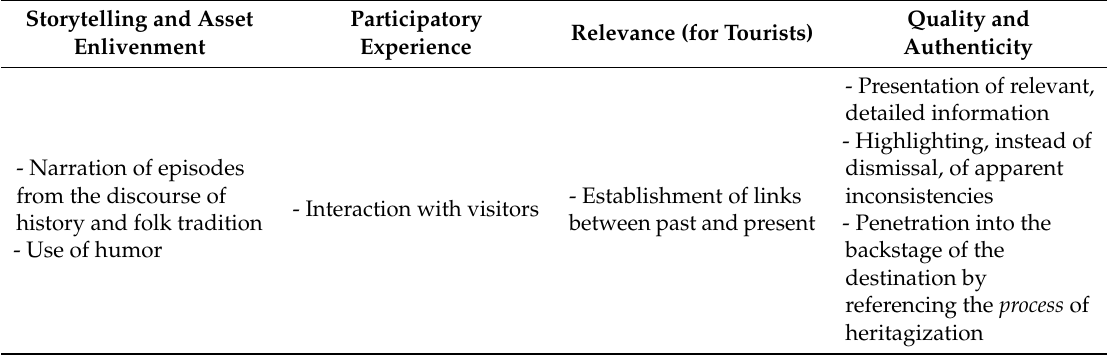
Table 2. Discursive strategies used in on-site